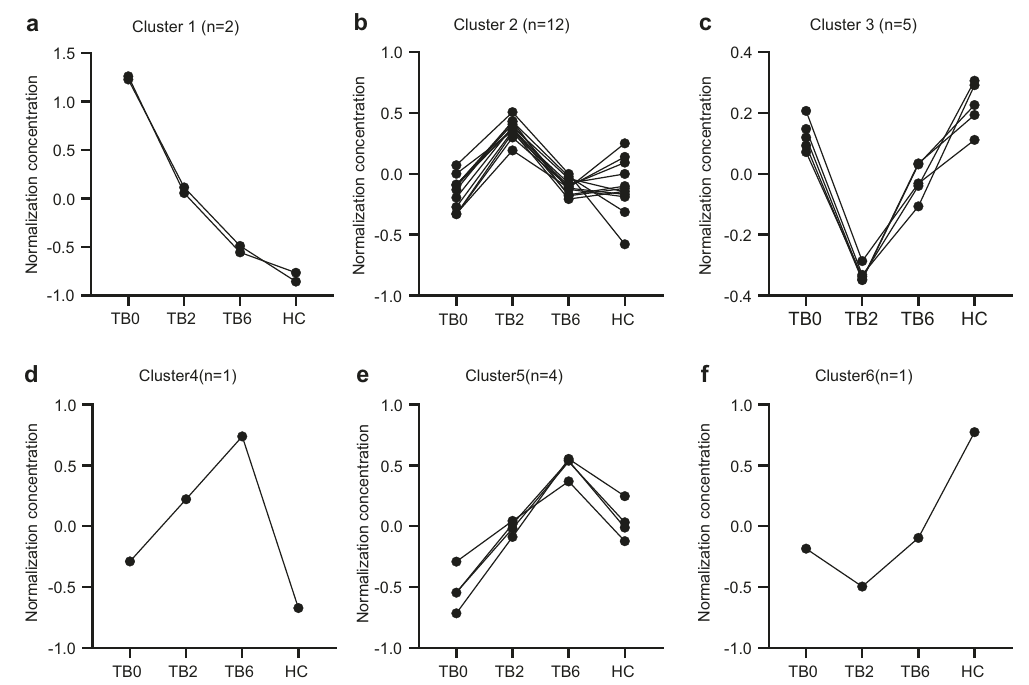
Fig. 3 K-means cluster showing 25 differential lipids among TB0, TB2, TB6, and HC groups. a The ordinate is the normalized lipid concentration. The abscissa is the TB0, TB2, TB6, and HC groups. Cluster 1 had a downward trend along with the TB0, TB2, and TB6 groups. b The lipid groups of cluster 2 showed an upward trend in the TB2 group, but similar low values in Tb0, TB6, and HC groups. c Cluster 3 had a downward trend in the TB2 group and an upward trend in the TB6 group. d Cluster 4 showed a single-lipid cluster, which was low in TB0 and HC groups but increased in TB2 and TB6 groups with antituberculosis treatment. e Cluster 5 had an upward trend along with the TB0, TB2, and TB6 groups. f Cluster 6 showed a single-lipid cluster, which was a high level in the HC group and low level in TB patients, especially in